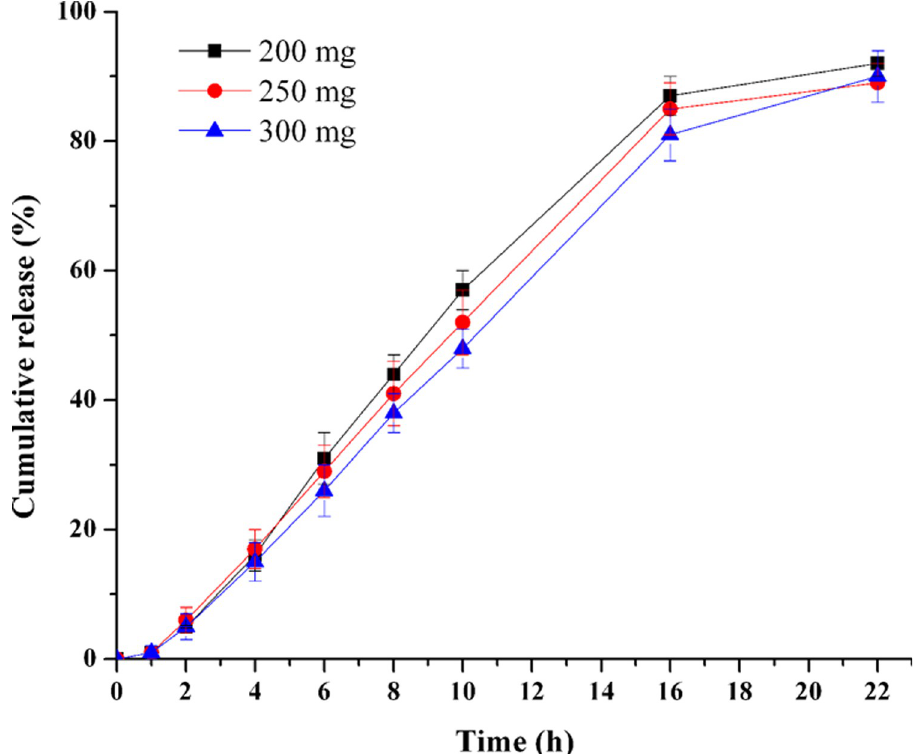
Fig 3. Effect of PEO amount in drug layer on the TPM release (n =